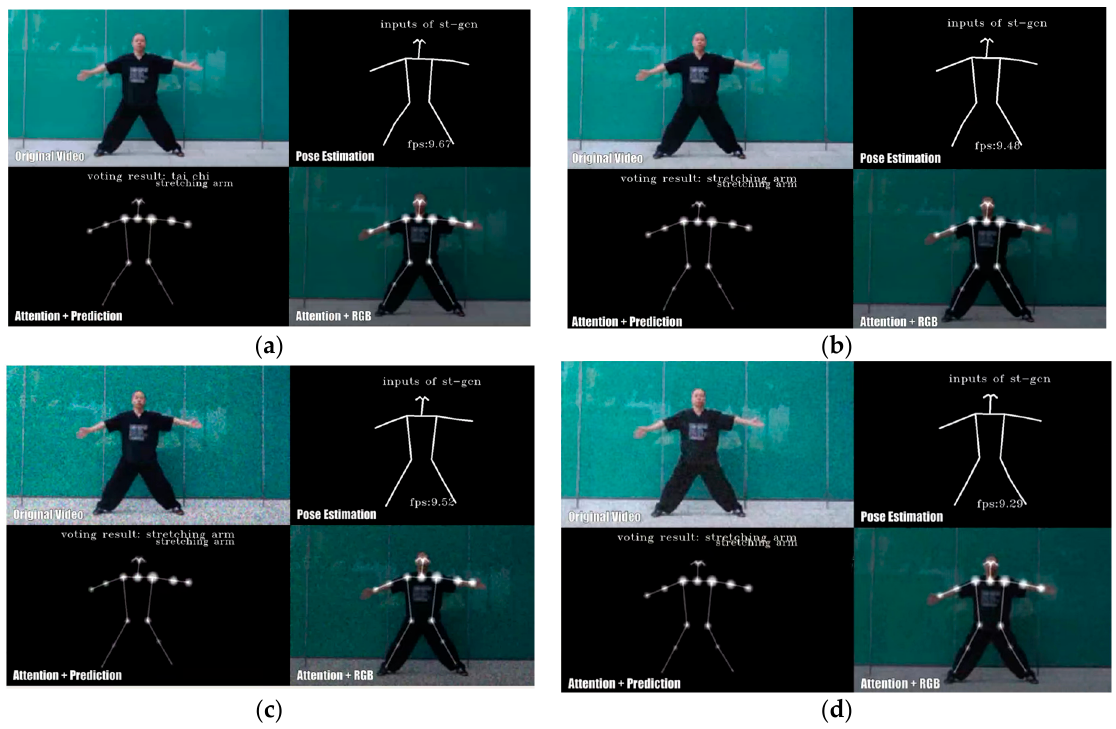
Figure 9. Data enhancement. Noise was added to the sample image. Figure ( a ) is the original image, Figure ( b ) adds Poisson noise, Figure ( c ) adds Speckle noise, and Figure ( d ) adds Gaussian noise.